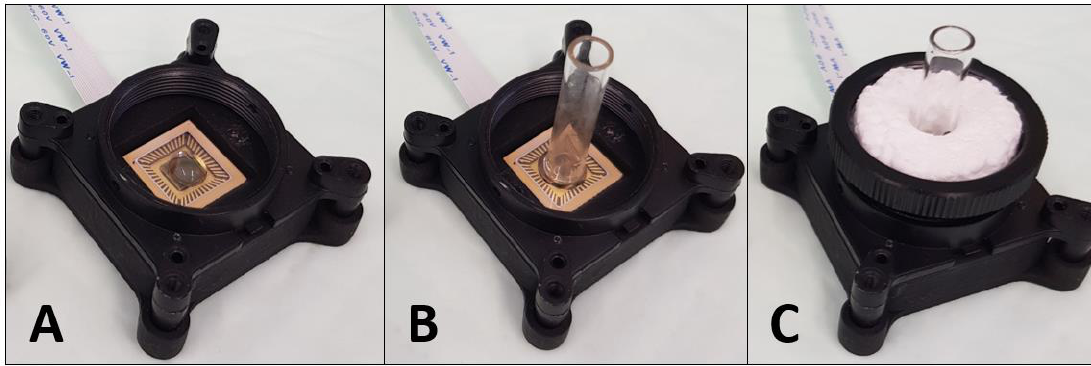
Figure 2. Picture of the CMOS-based biosensor system setup. ( A ) the enzymatic reaction of the horseradish peroxidase (HRP) enzyme was activated by the deposition of a 20 µL substrate solution ((1:1) luminol: H 2 O 2 ( v / v )), ( B ) while the glass tubes were still placed above the CMOS sensor. ( C ) A